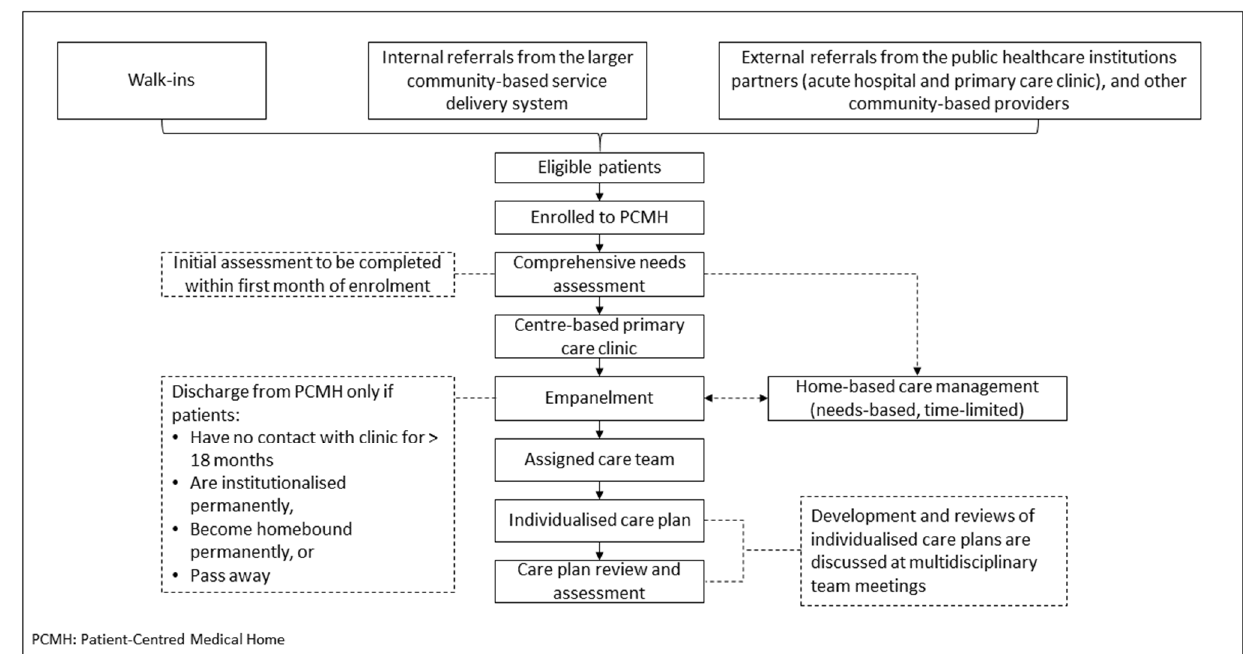
Figure 1. Patient Flow Diagram.